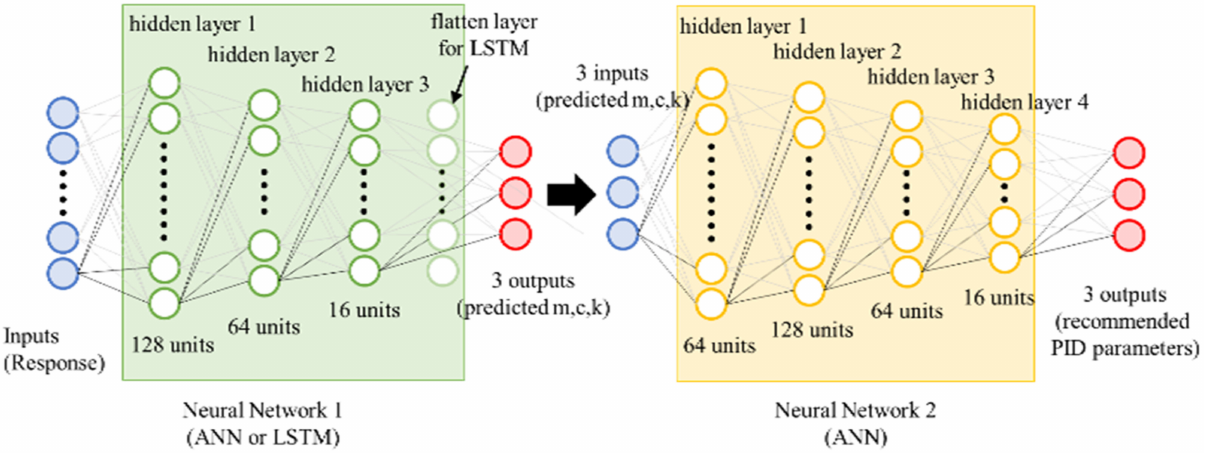
Figure 3. Architectures of the two proposed neural networks.